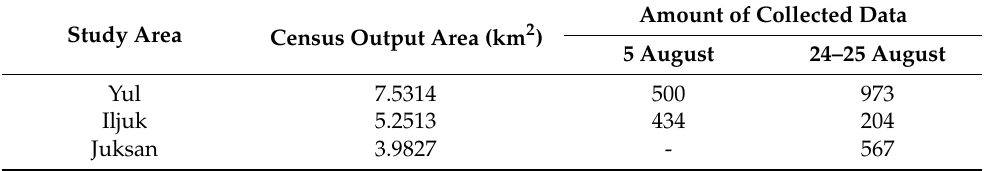
Table 2. Experiment